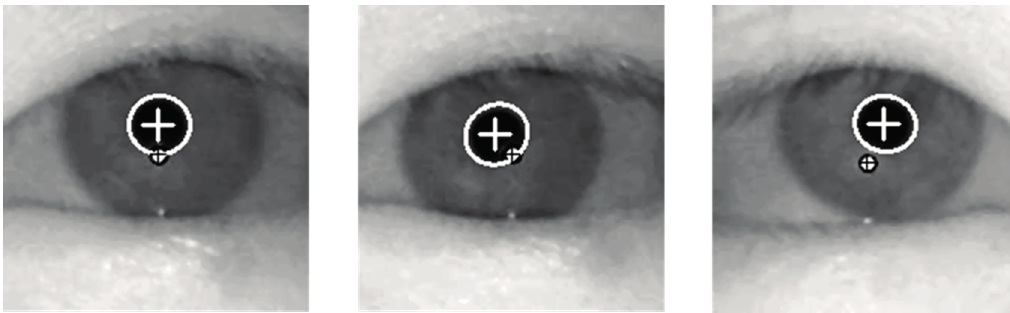
Figure 10. The examples of detected pupil center and corneal